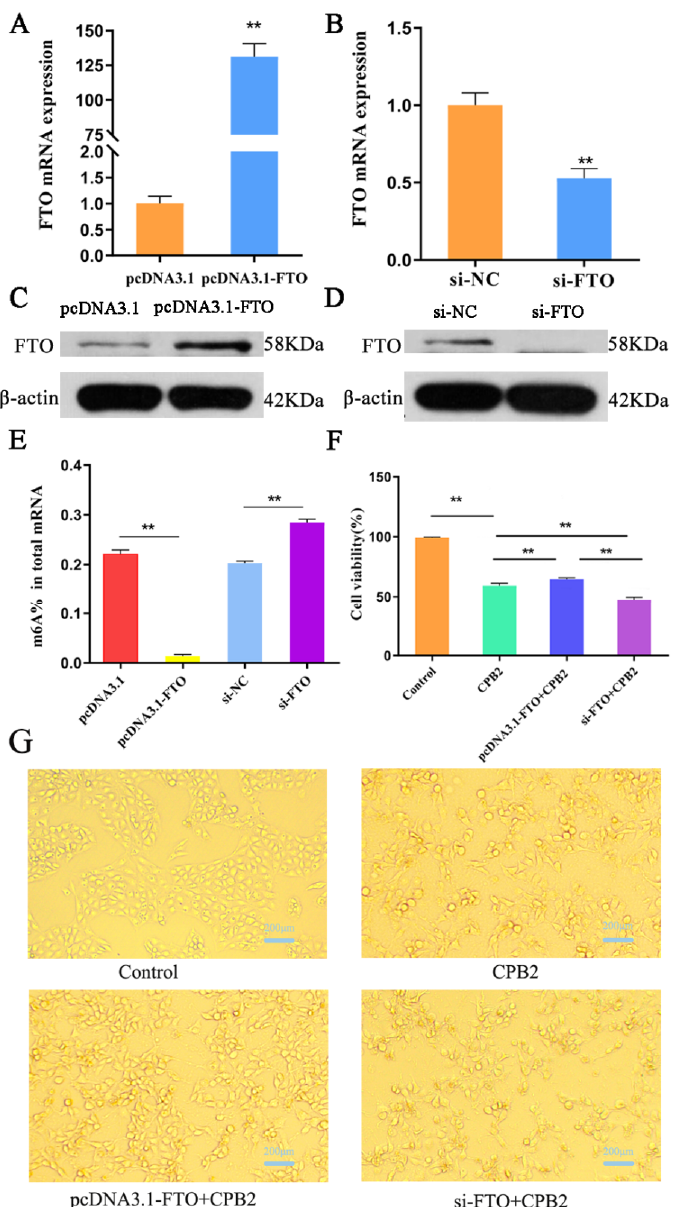
Figure 3. FTO influences on the viability of CPB2 toxin-treated IPEC-J2 cells. qRT-PCR ( A , B ) and Western blotting ( C , D ) confirmation of FTO knockdown and overexpression in transfected IPEC-J2 cells. The total m6A content in FTO-overexpressing or silenced IPEC-J2 cells ( E ). Effect of CPB2 on the viability of FTO overexpressing or silenced IPEC-J2 cells ( F ). The morphological changes in CPB2-treated FTO overexpressing or silenced IPEC-J2 cells. Scale bar = 200 μ m ( G ). (** p < 0.01). Original western blot figures in Figure S1.